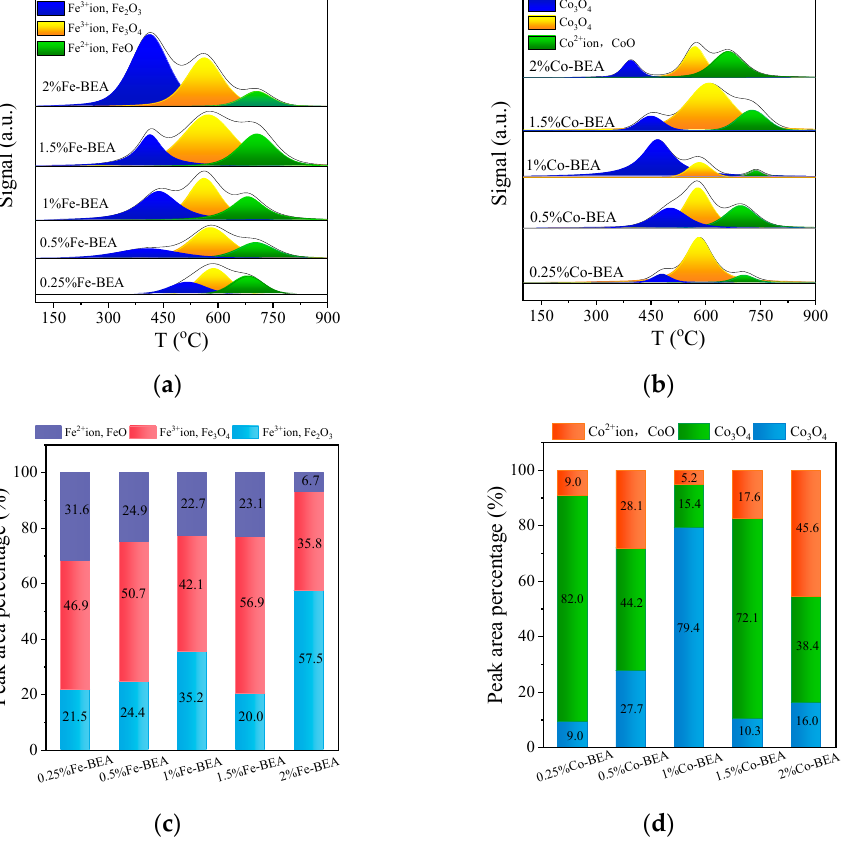
Figure 5. ( a ) H 2 − TPR profiles of Fe-BEA with different concentrations; ( b ) H 2 − TPR profiles of Co-BEA with different concentrations; ( c ) proportion of species corresponding to hydrogen consumption peak of Fe-BEA; ( d ) proportion of species corresponding to hydrogen consumption peak of Co-BEA.